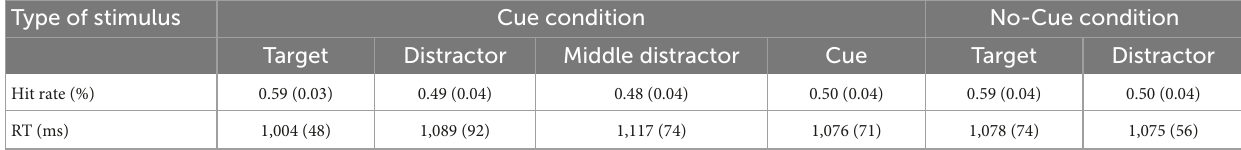
TABLE 2 Overall performance on word recognition test in Experiment 2.